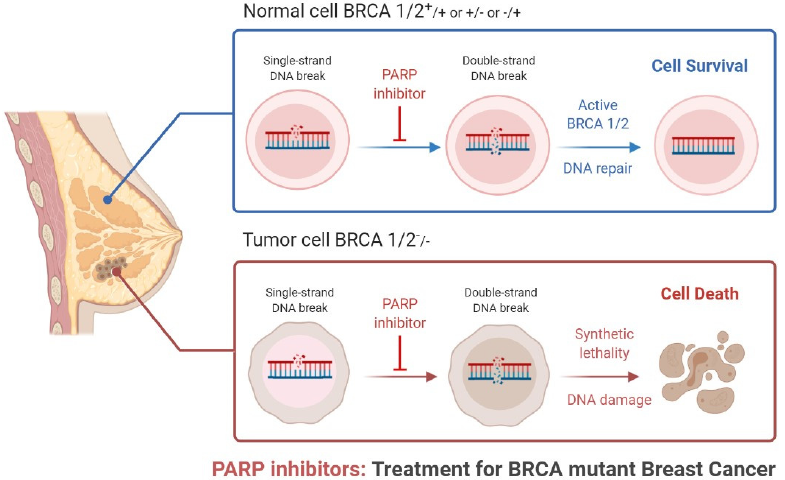
Figure 1. Role of PARP inhibitors in treatments for BRCA mutant breast cancer.